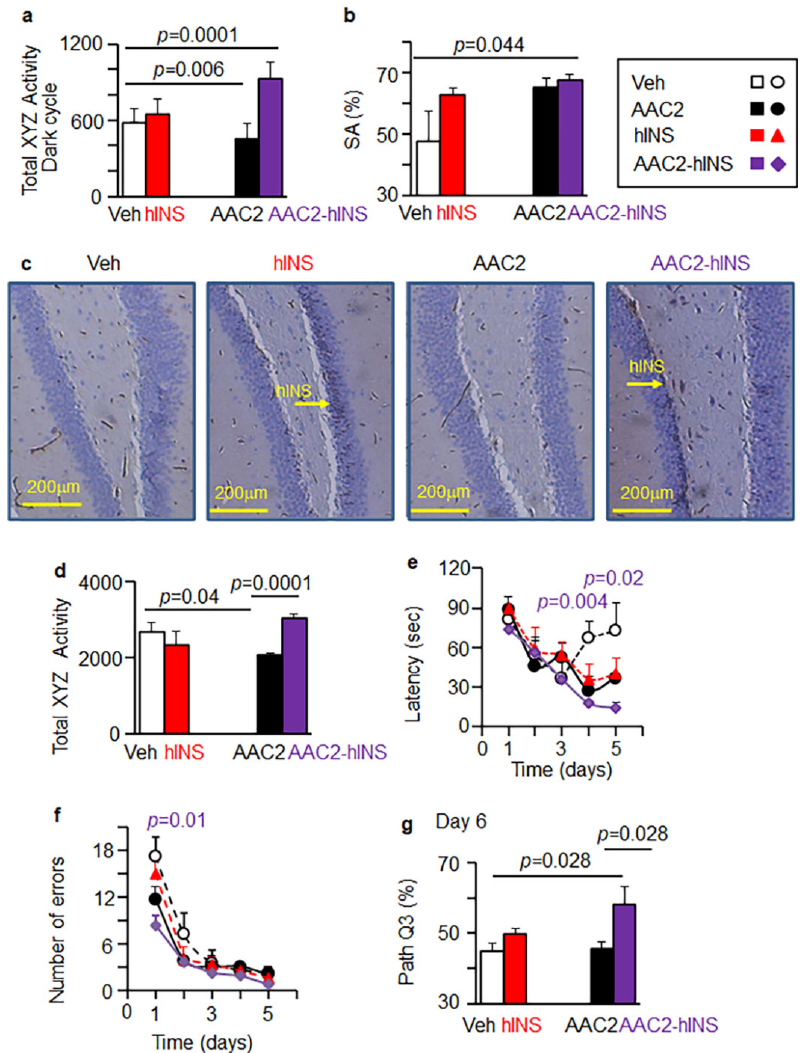
Figure 7. AAC2-hINS treatment improved physical activity and cognitive performance in STZ and genetic mouse models of T1D. ( a ) Activity of mice in XYZ directions in STZ mice was measured during the active dark period using CLAMS. Student’s t ‐ test. ( b ) Spontaneous alteration (% SA) in STZ mice was measured 3–4 weeks post treatment. One ‐ way ANOVA. ( c ) Representative images of protein expression of hINS (brown staining, yellow arrows) in the hippocampus of STZ mice treated with Veh, hINS, AAC2, AAC2 ‐ hINS ( n = 3/group). ( d ) Activity of mice in XYZ directions in Ins2 Akita mice ( n = 5/group) was measured during the active dark period using CLAMS. Student’s t ‐ test. ( e , f ) Barnes Maze test was performed with Ins2 Akita mice after 7 weeks post ‐ treatment ( n = 5/group). In the training period (Day 1~5), latency ( e ) and a number of errors ( f ) were measured. Differences were compared for each day by Student’s independent t ‐ test. Significant differences between control and AAC2 ‐ hINS ‐ treated mice on days 4 and 5 were p = 0.004 and 0.02, respectively. At baseline, the control group presented significantly more errors compared to the AAC2 ‐ hINS treated group ( p = 0.01). ( g ) Hole escape time at day 6 (Q3 in same Barnes Maze experiment). Overall comparison p = 0.026.